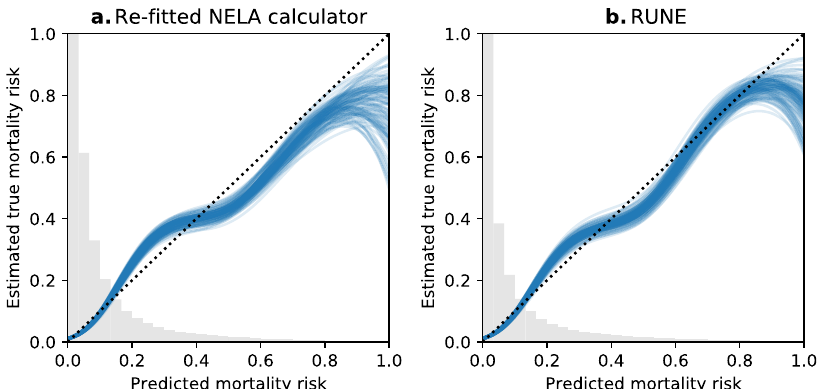
Fig. 3 Calibration curves. Calibration curves are shown for the re- fi tted NELA Calculator ( a ) and RUNE ( b) . Each of the 120 curves for each model is derived using one of the 120 validation sets in the cross-validation. Grey histograms show the distribution of each model ’ s predicted mortality risks (the range of point estimates of risk across all cases) across all validation sets.